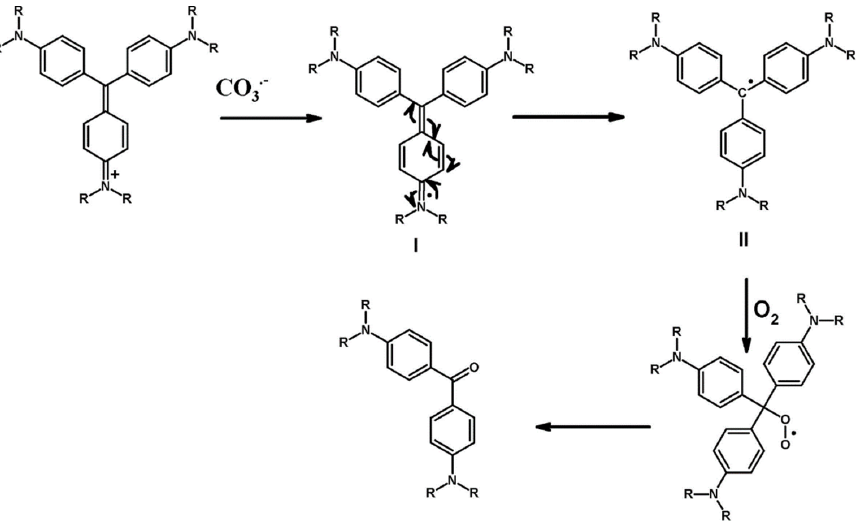
Figure 4. The destruction of TPM dyes induced by CO 3 ● - . Reprinted with permission from